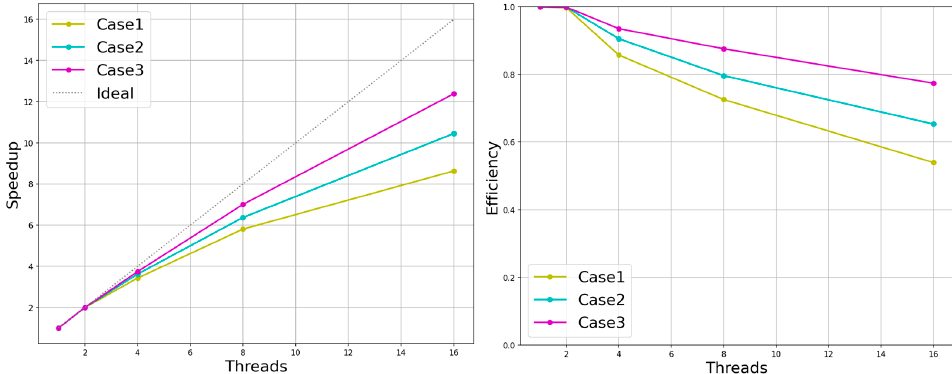
Figure 25. Speed-up and efficiency in the three different groups of grid structures.